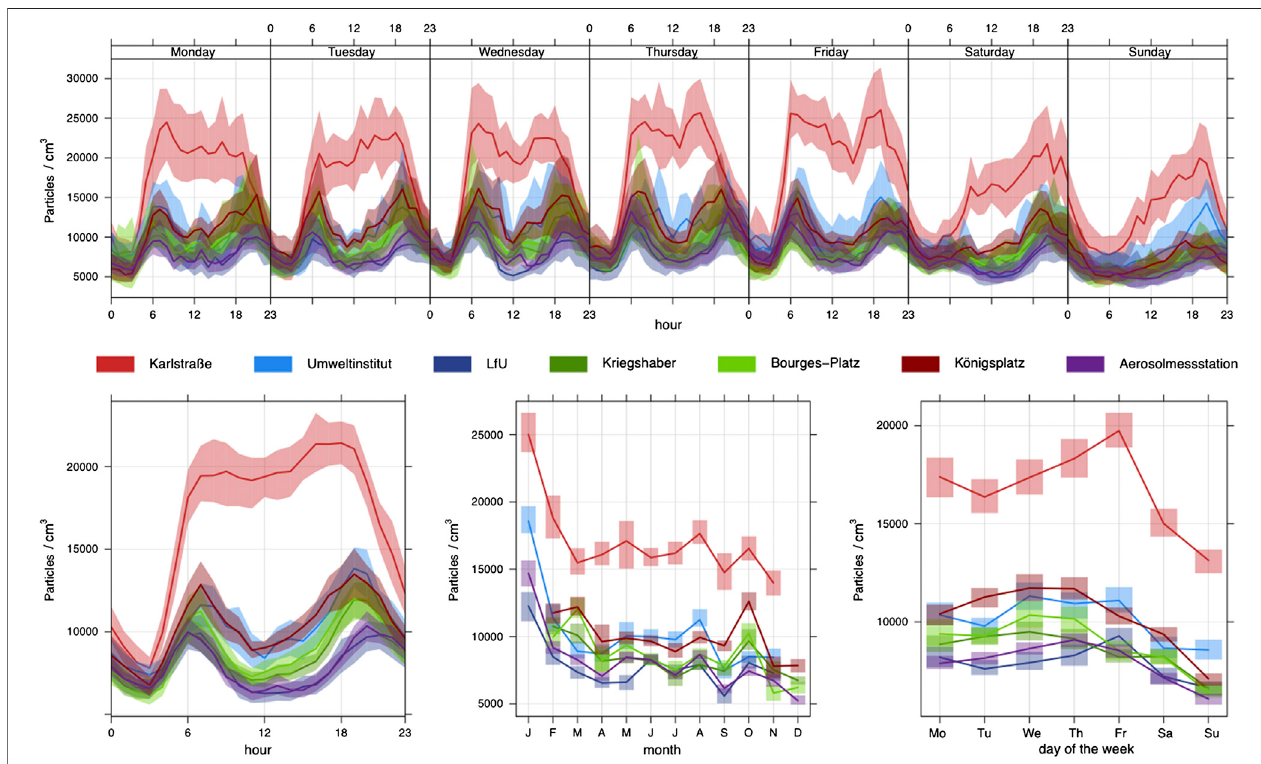
FIGURE 8 | Daily (bottom left), weekly (top: hourly averages, bottom right: daily averages) and annual cycles (bottom center) of the hourly UFP number concentrations from the measurement campaign 2017 [lines: mean values; shaded areas: fl uctuation range between 5th and 95th percentile].